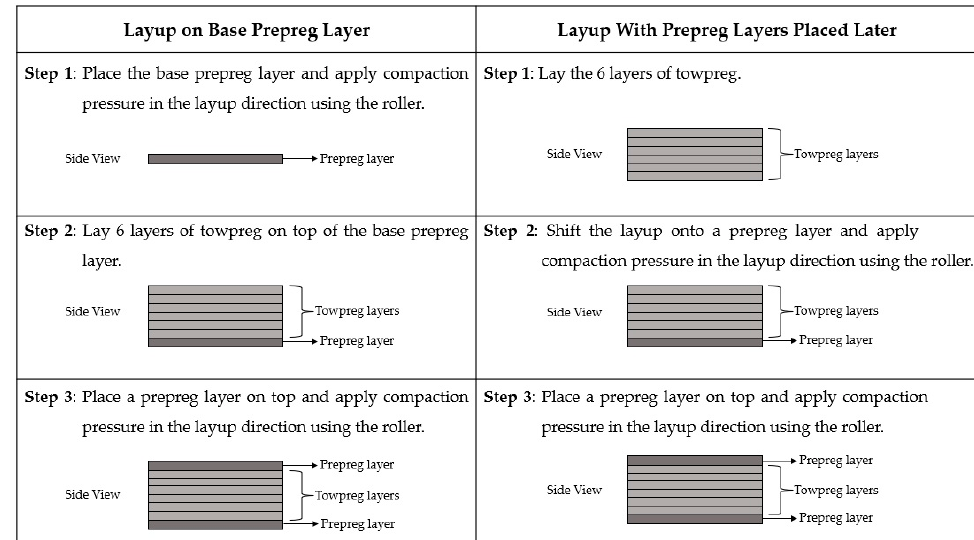
Figure 3. Different layup types and the associated steps. Table 1 summarizes the nomenclature of all twelve fabricated laminates. Table 1. Specimen nomenclature based on roller pressure and base prepreg layer. Sr.